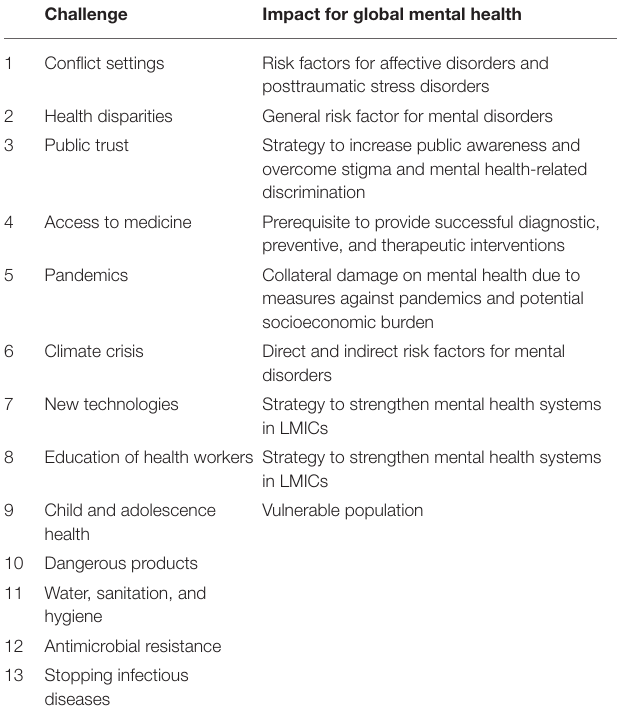
TABLE 1 | Grand challenges in global (mental)